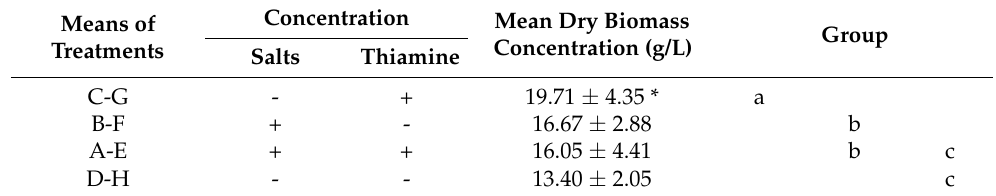
Table 5. Dry biomass concentration for each pair of treatments analyzed by Tukey’s multiple comparison test for the salt–thiamine interaction, n = 3.